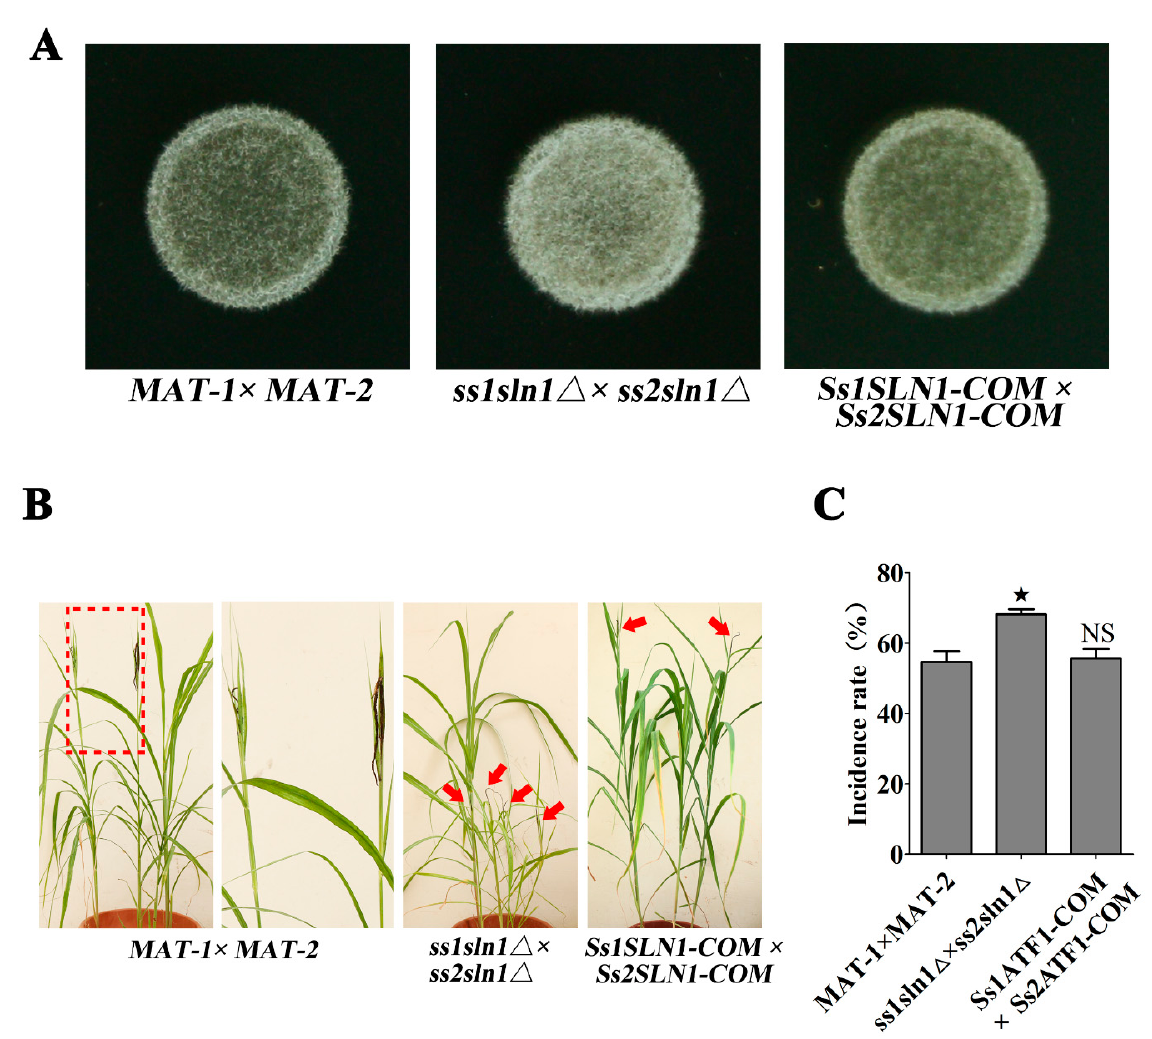
Figure 2. Effect of SsSln1 on mating and virulence. ( A ) Mating assay of mutants. Fresh haploid sporidia were grown up to O.D.600 = 1.0, and then mixed with an equal volume of the compatible WT strain or mutants and spotted onto YePSA medium to incubate at 28 °C. Images were taken after 30 h of cultivation. ( B ) Pathogenicity assay of SsSln1 null mutants. A susceptible sugarcane variety ROC22 was inoculated with mixed sporidia ( 1 : 1 ) of S. scitamineum and wild-type or mutant combination via injection at the 5–6-leaf seedling stage. The infection assays were performed with at least 15 seedlings. The symptoms of ‘black whip’ were documented and photographed at about six months post inoculation. The red dotted box regions were enlarged for a better view of whip symptoms. The symptoms of ‘black whip’ are denoted by red arrows. ( C ) Bar chart depicts the quantification of infection as shown in ( B ). Percentage (%) of ‘black whip’/total seedlings is (cid:70) p indicated. Bar chart depicts the statistical differences among the mean values ( < 0.05). Mean ± S.E. were derived from two independent biological repeats with three